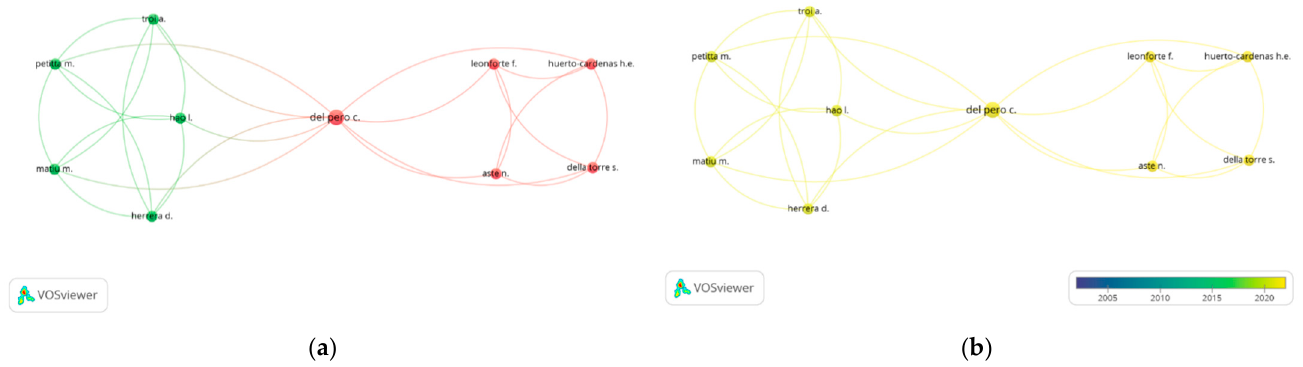
Figure 7. Co-authorship analysis (ten authors relation) per ( a ) cluster, and ( b ) year of pub-